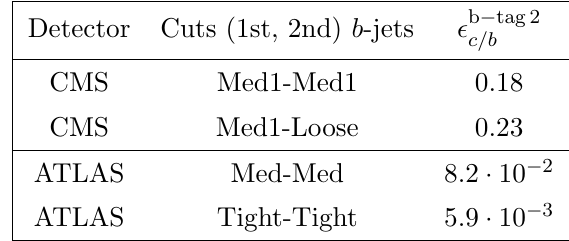
Table 4 . The b -tagging working points used in the analysis, for CMS [100] and ATLAS